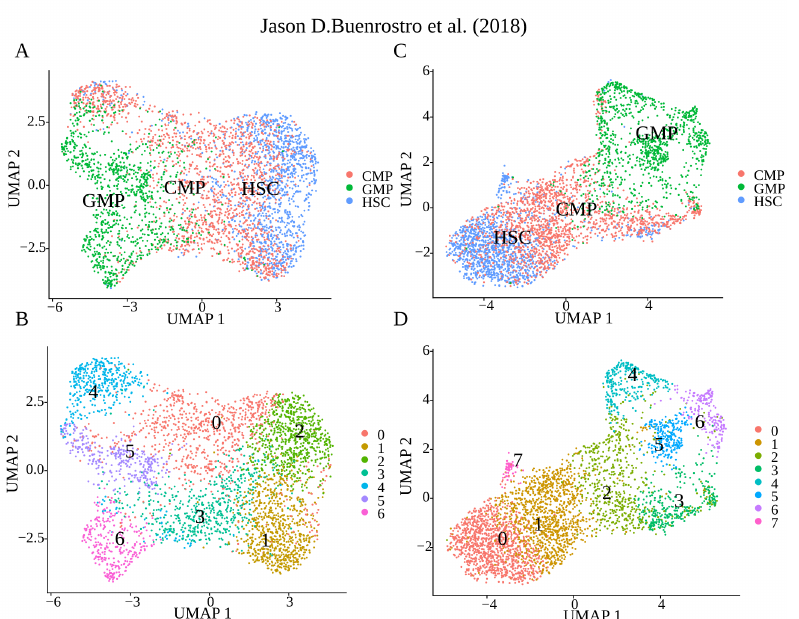
Figure 3. Epi-impute effect on clustering [18]: ( A ) Epi-impute imputed dataset, cell types determined based on surface markers. ( B ) Epi-impute imputed dataset, de novo clusters obtained by Seurat. ( C )Raw dataset, cell types determined based on surface markers. ( D ) Raw dataset, Image shows the division de novo clusters obtained by